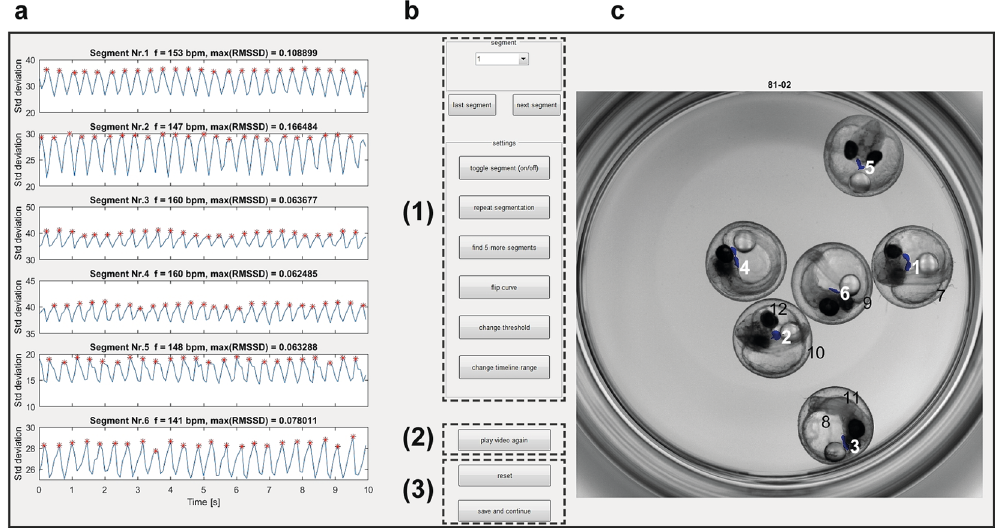
Figure 2. Functionalities of HeartBeat software. ( a – c ) Graphical user interface of the HeartBeat software for computer-assisted semi-automated analysis allowing convenient and rapid quality check. ( a ) Standard deviations of pixel values relating to segmented heart regions are displayed over time in the left panel, where heartbeats are indicated by red asterisks for each image sequence. ( b ) A control panel allows (1) to refine settings of segmentation and to choose alternative segments, (2) to re-play the current image sequence (visualized in c ), (3) to reset all settings or to save heart rates to spreadsheets together with a picture of segmented image sequence. ( c ) Visualization of the image sequence with segmented heart regions displayed as numbered blue areas (detailed manual available together with software in Supplementary material online).